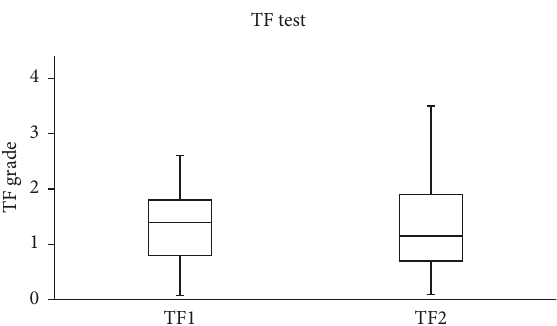
Figure 4: Side-by-side boxplots for the TF grades for the study group before (TF1) and after wearing (TF2) a face mask.